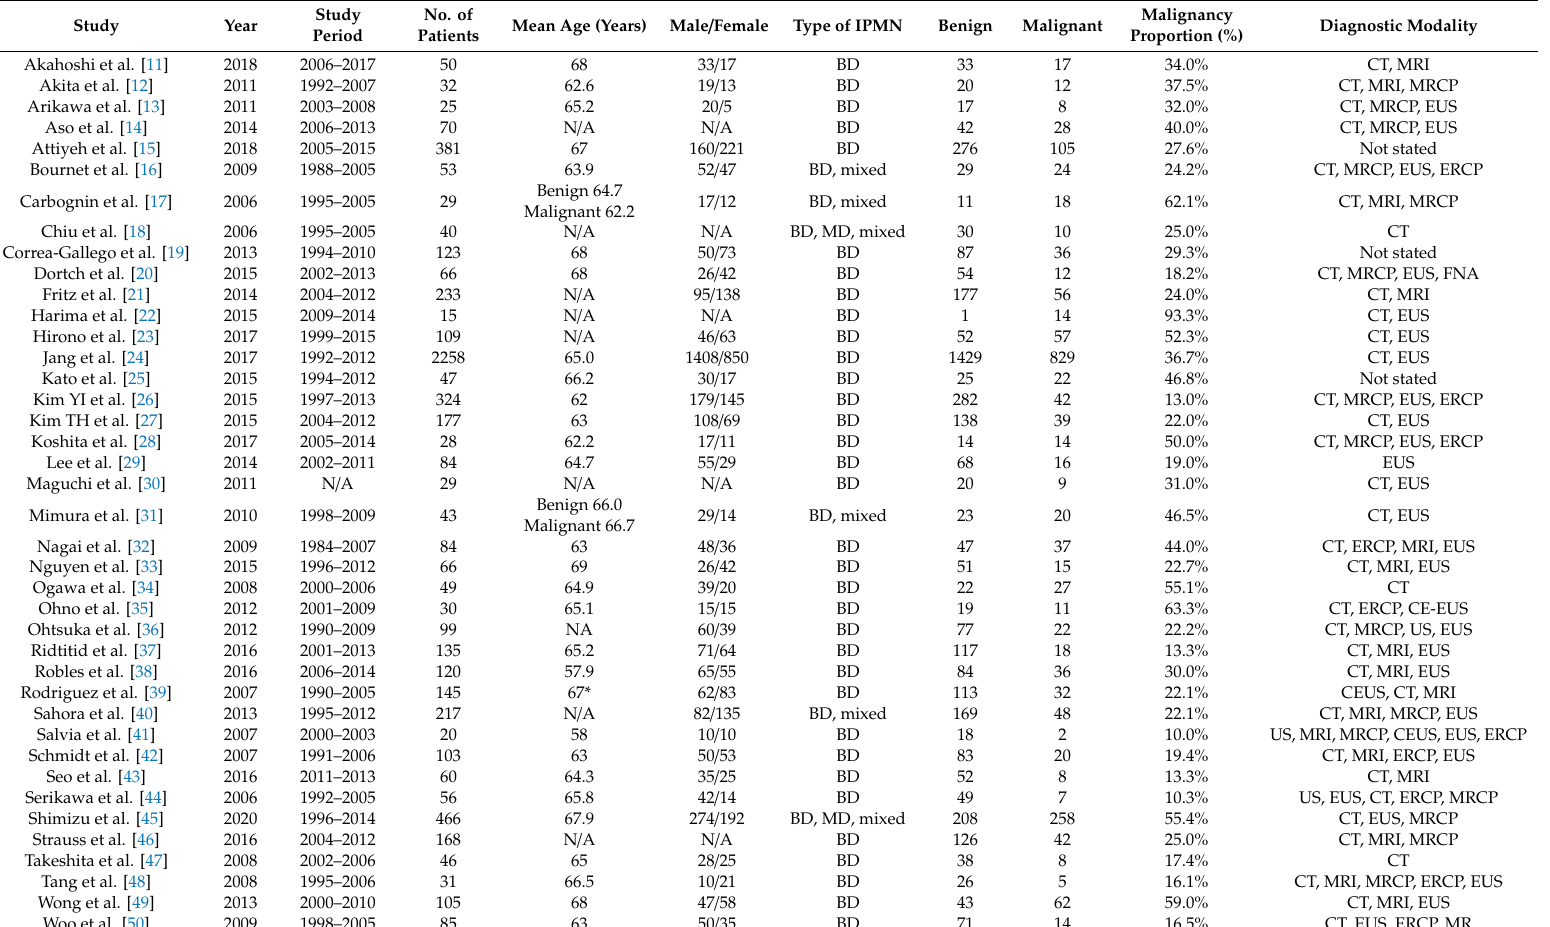
Table 1. Characteristics of included